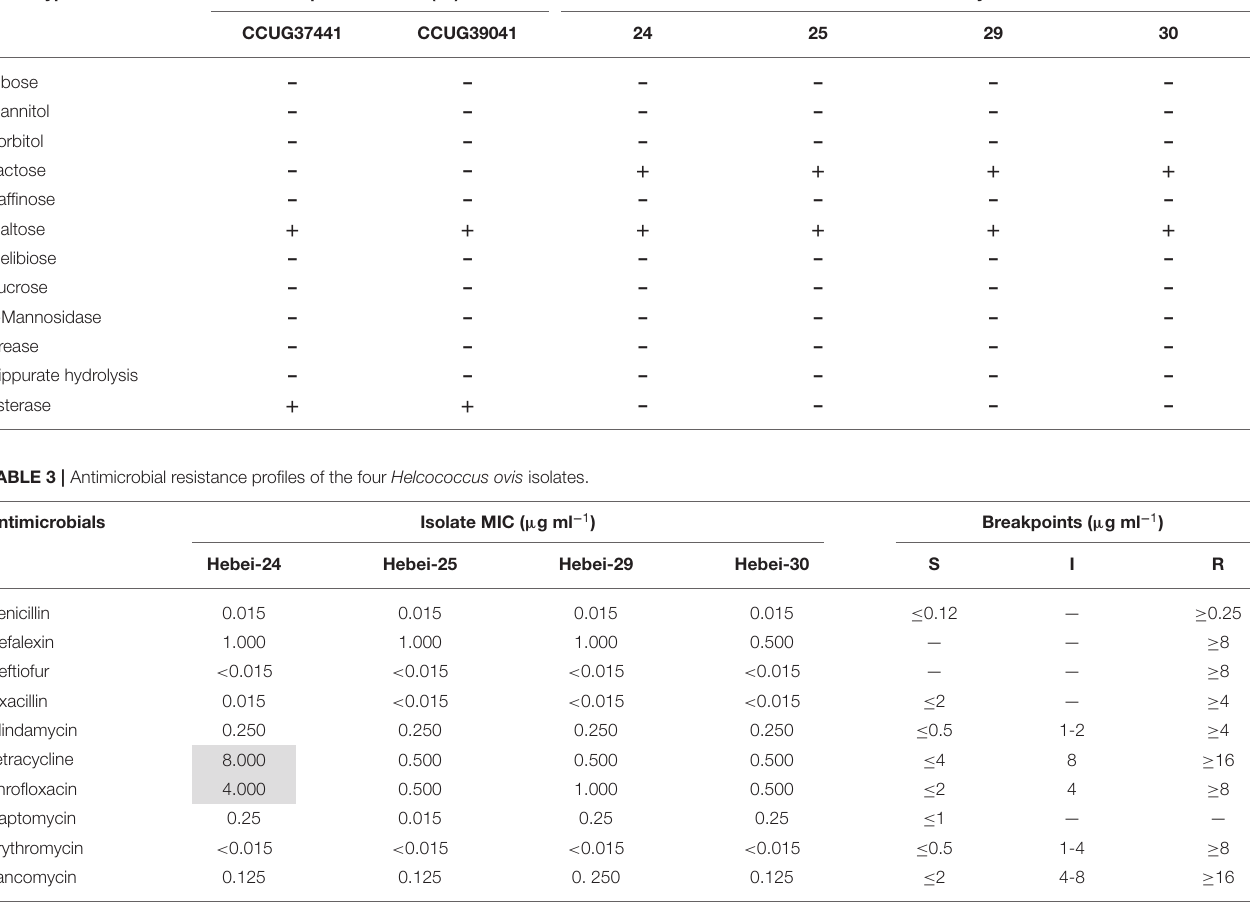
TABLE 2 | Biochemical characteristics of the four Helcococcus ovis isolates. Phenotypic characteristic